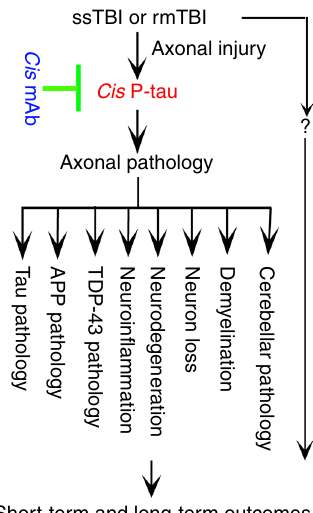
Fig. 9 A model for the roles of cis P-tau and its mAb in the development and treatment of ssTBI and rmTBI. ssTBI or rmTBI causes persistent and robust cis P-tau induction before other tau pathology likely due to axon injury. Cis P-tau mainly localizes to axons and causes and spreads axonal pathology, contributing to the development and progression of a range of neuropathological and functional outcomes during acute and chronic phases, including those pathological features resembling human CTE. Treatment of ssTBI or rmTBI mice with cis mAb not only eliminates cis P- tau and blocks its spreading, but also prevents the development and progression of a range of neuropathological and functional outcomes after